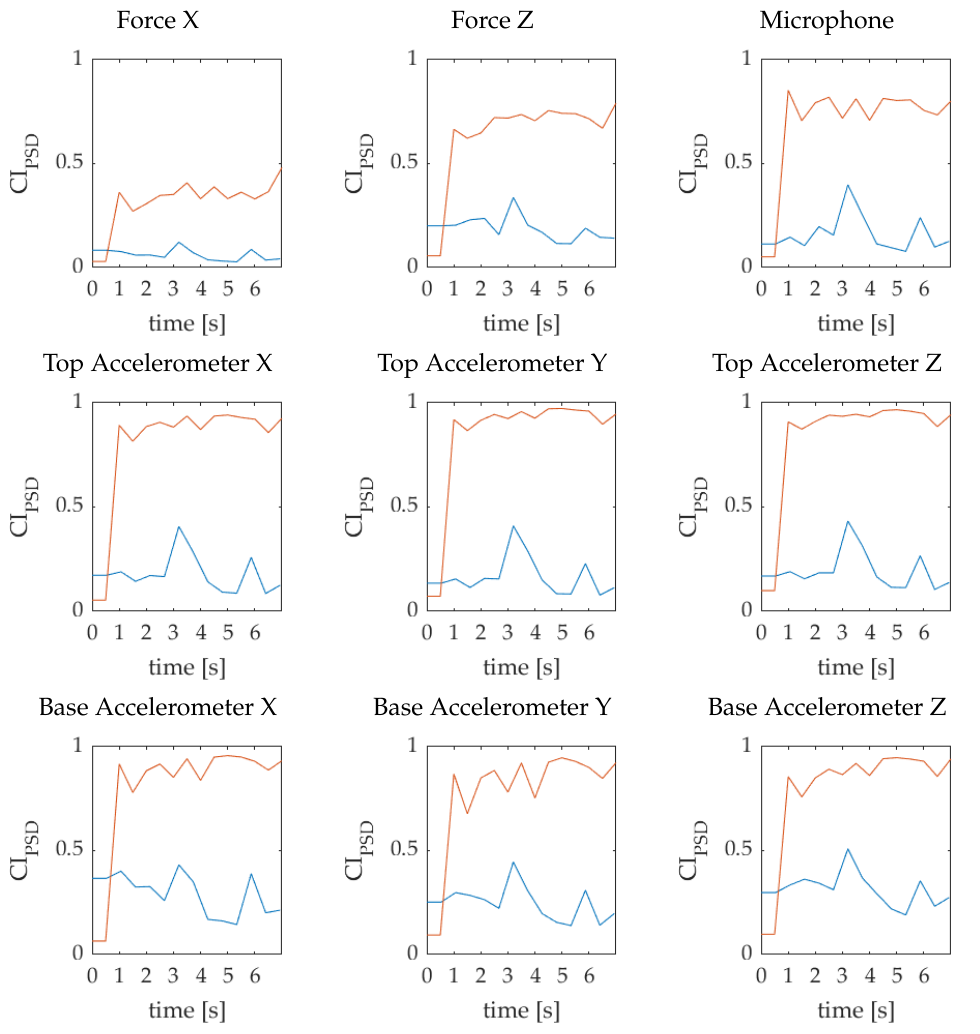
Figure 9. PSD chatter indices: Blue for stable process—red for unstable